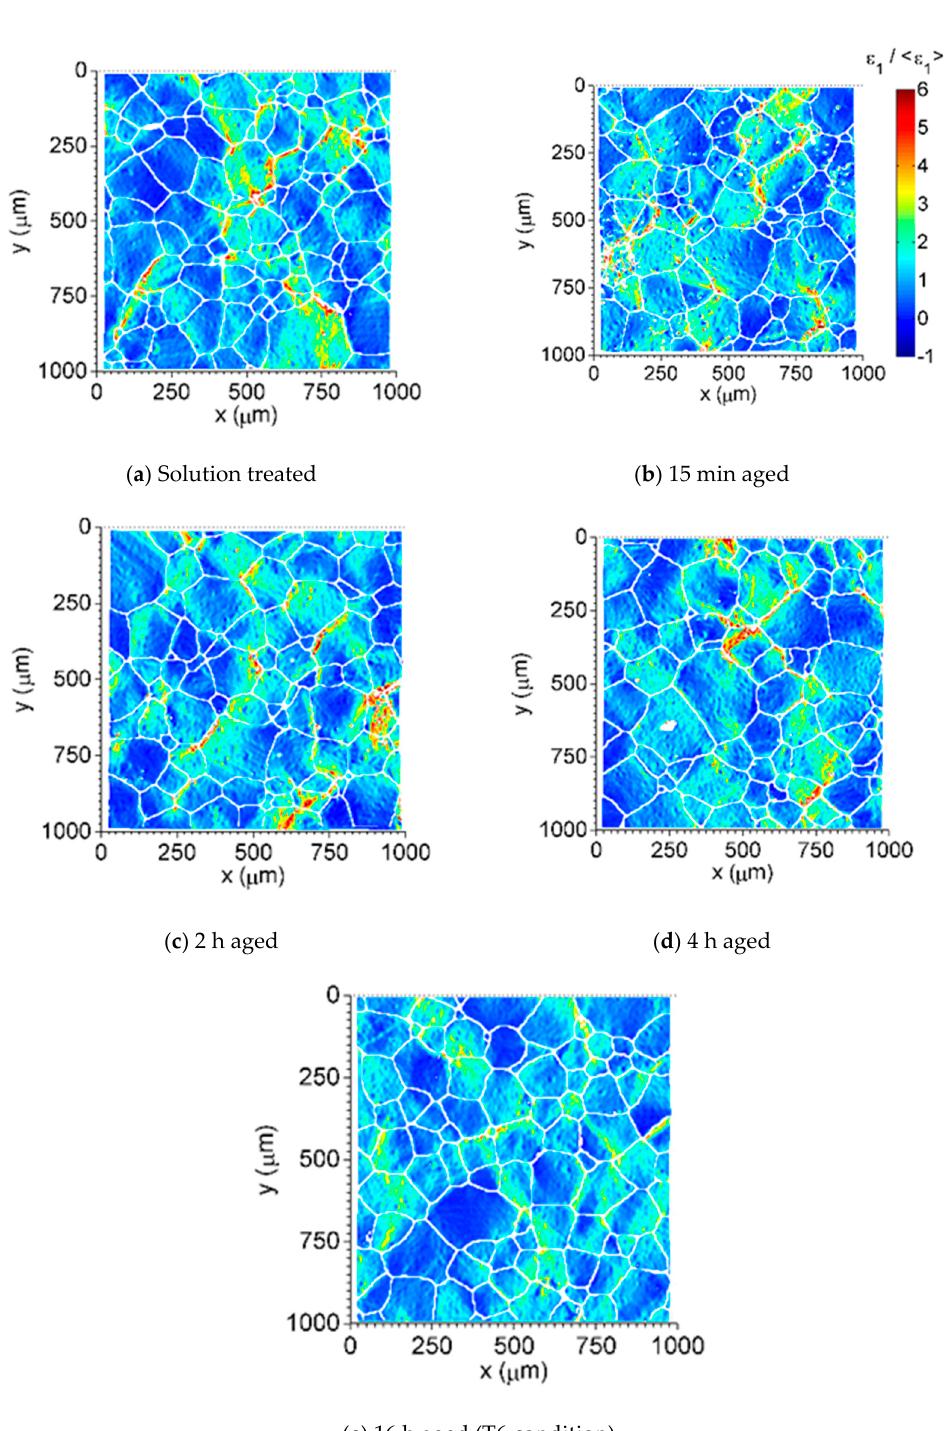
Figure 22. The effect of heat treatment condition on normalized maximum principal strain map subjected to a uniaxial tension along the rolling direction at a strain of ε = − 3.23% for different heat treatment conditions of: ( a ) Solution treated, ( b ) 15 min aged, ( c ) 2 h aged, ( d ) 4 h aged, ( e ) 16 h aged (T6 condition) (After Ganesan et al. [8]).